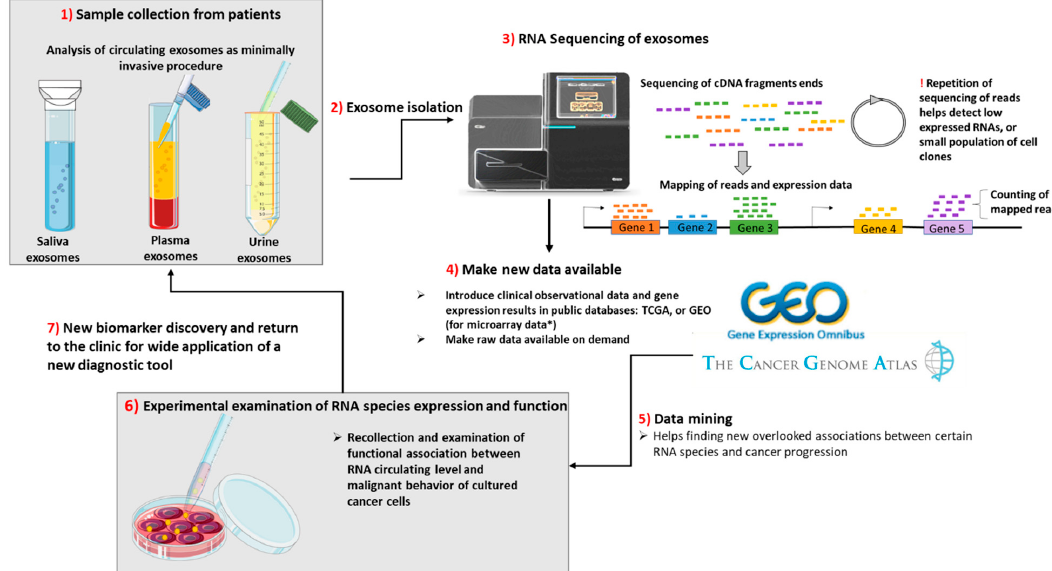
Figure 2. From the collection of samples from patients undergoing minimally invasive procedures until the discovery of new biomarkers of a cancer type or for the assessment of cancer progression, there are 7 steps to be taken. ( 1 ) The samples are collected from patients and processed separately by centrifugation at low speed for the separation of exosomes from other heavier particles, such as cells. Then, through high speed ultracentrifugation or differential centrifugation, the next step is taken. ( 2 ) Exosome isolation. ( 3 ) The purified exosomes are sequenced during RNASeq: first, the total or small RNA is purified; then, it is reversed transcribed into cDNA, fragmented and labeled. The cDNA fragments are sequenced, and the reads are mapped to the genome of reference. During deep sequencing technologies, the repetition of sequencing is greater; thus, the genes that have a very low level of expression can be more easily identified. ( 4 ) The RNA Seq or microarray data (the microarray technology was not presented) should be made public by uploading the sequencing data along with clinical characteristics of the analyzed samples on publicly available databases, such as the Cancer Genome Atlas (TCGA) or Gene Expression Ominibus (GEO). In addition, if required, the authors should provide the RNASeq raw data. ( 5 ) Data mining. By accessing the above-mentioned databases, other scientific groups may find new associations between gene expression and clinical data. ( 6 ) In order to test for a causative correlation between RNA species expression and function, the in vitro testing and collection of exosomes from supernatant are needed. After definitive results in pre-clinical data, if the new RNA species show high sensitivity and specificity, comparable with that of the current biomarkers, they will be introduced in common clinical practice. ( 7 ) New biomarker discovery for wide application of a new diagnostic tool.